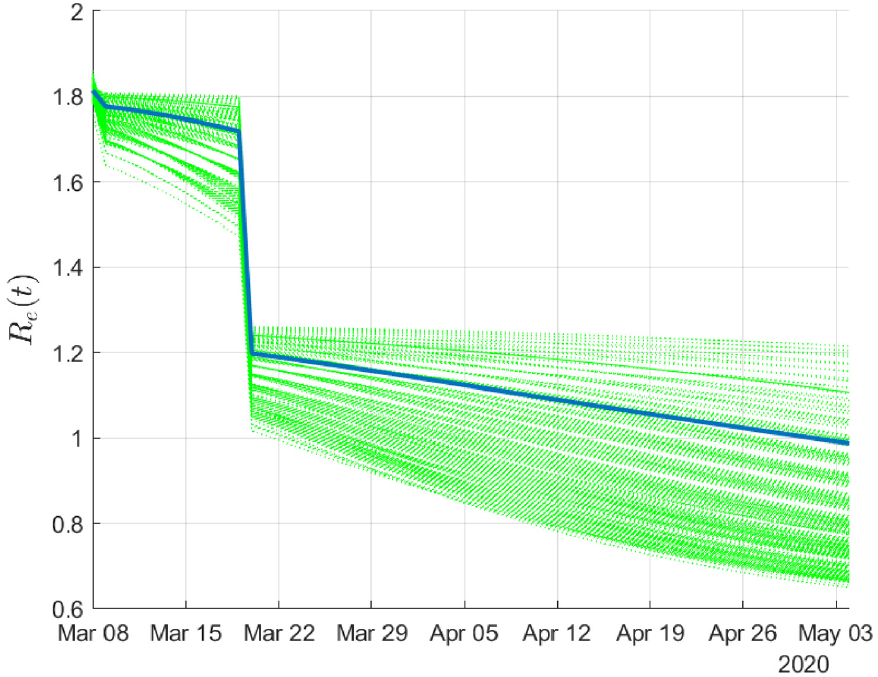
Fig 7. Evolution of the effective reproduction number. The solid line depicts the mean value of the